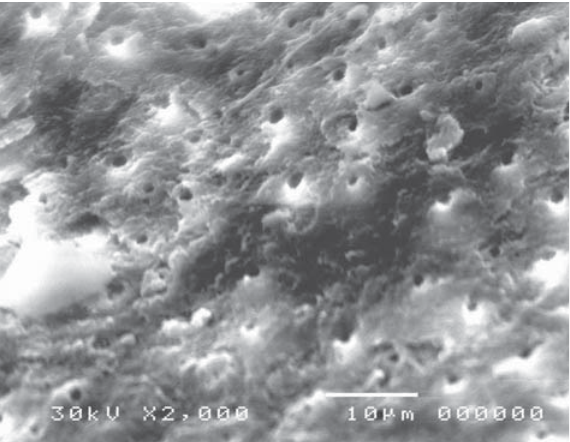
Figure 12- Electron-micrograph in gamma (GL) group subjected to laser showing dentine surface after cavity preparation. (cid:38)(cid:82)(cid:81)(cid:192)(cid:88)(cid:72)(cid:81)(cid:70)(cid:72)(cid:3)(cid:82)(cid:73)(cid:3)(cid:87)(cid:88)(cid:69)(cid:88)(cid:79)(cid:68)(cid:85)(cid:3)(cid:68)(cid:81)(cid:71)(cid:3)(cid:76)(cid:81)(cid:87)(cid:72)(cid:85)(cid:16)(cid:87)(cid:88)(cid:69)(cid:88)(cid:79)(cid:68)(cid:85)(cid:3)(cid:86)(cid:87)(cid:85)(cid:88)(cid:70)(cid:87)(cid:88)(cid:85)(cid:72)(cid:86)(cid:3)(cid:76)(cid:86)(cid:3)(cid:81)(cid:82)(cid:87)(cid:72)(cid:71)(cid:3)(cid:76)(cid:81)(cid:3)(cid:86)(cid:82)(cid:80)(cid:72)(cid:3) areas, while in other areas, the tubular structure is maintained and reveals variation in tubular diameter (blue arrow), (x500)